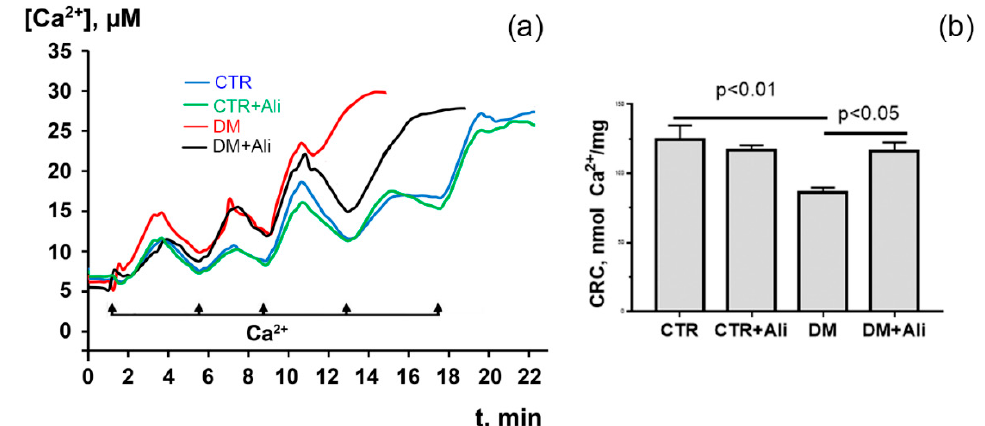
Figure 3. Changes in the external [Ca 2+ ] upon successive addition of small Ca 2+ doses (10 µ M) to the suspension of heart mitochondria of experimental animals ( a ). Ca 2+ retention capacity of heart mitochondria of experimental animals ( b ). The values are given as means ± SEM ( n = 5).